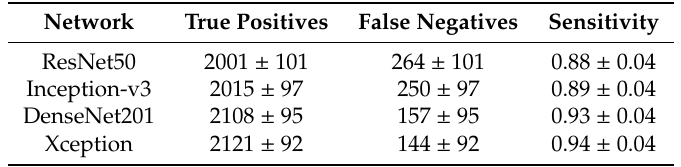
Table 10. Test Performance using our recommended systems on BIMCV dataset that employed preprocessing and transfer-to-transfer